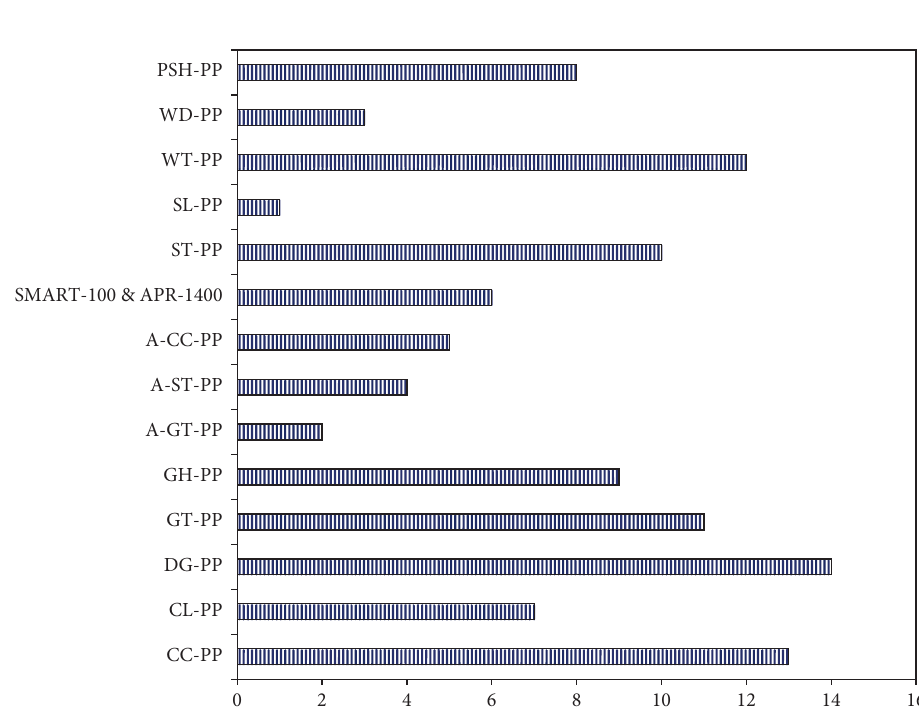
Figure 17: Ranking of power plant technologies by 2050 for Subscenario